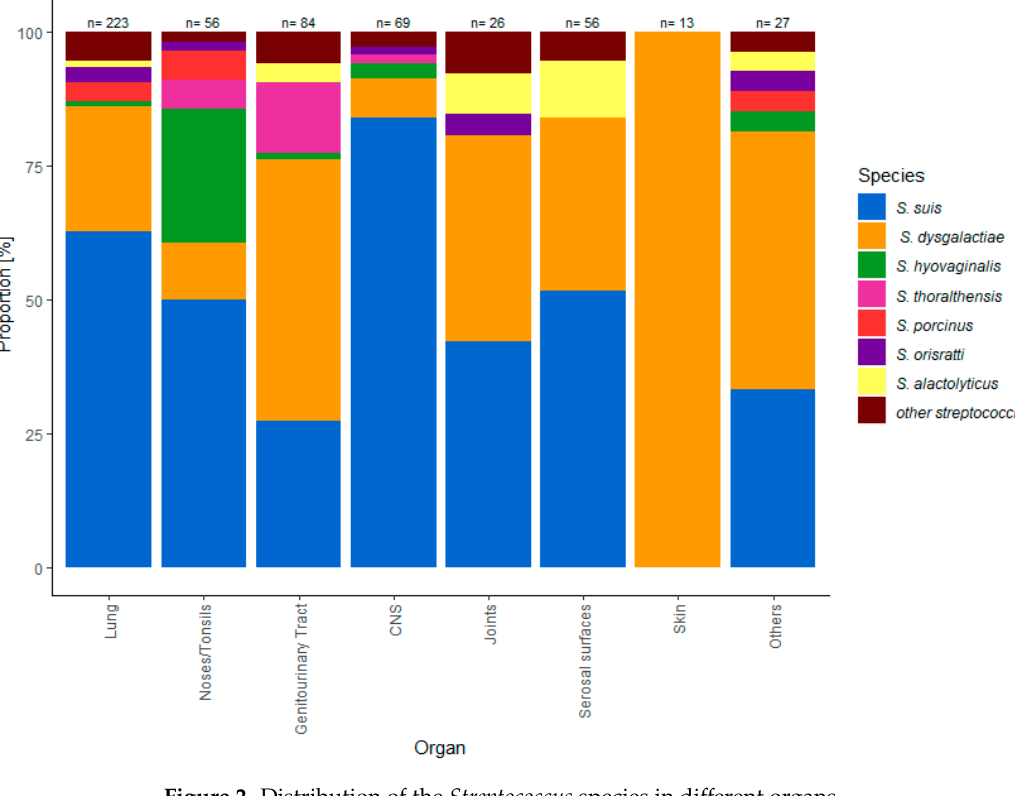
Figure 2. Distribution of the Streptococcus species in different organs. Table 2. Frequency of resistances in the examined Streptococcus spp. [%]